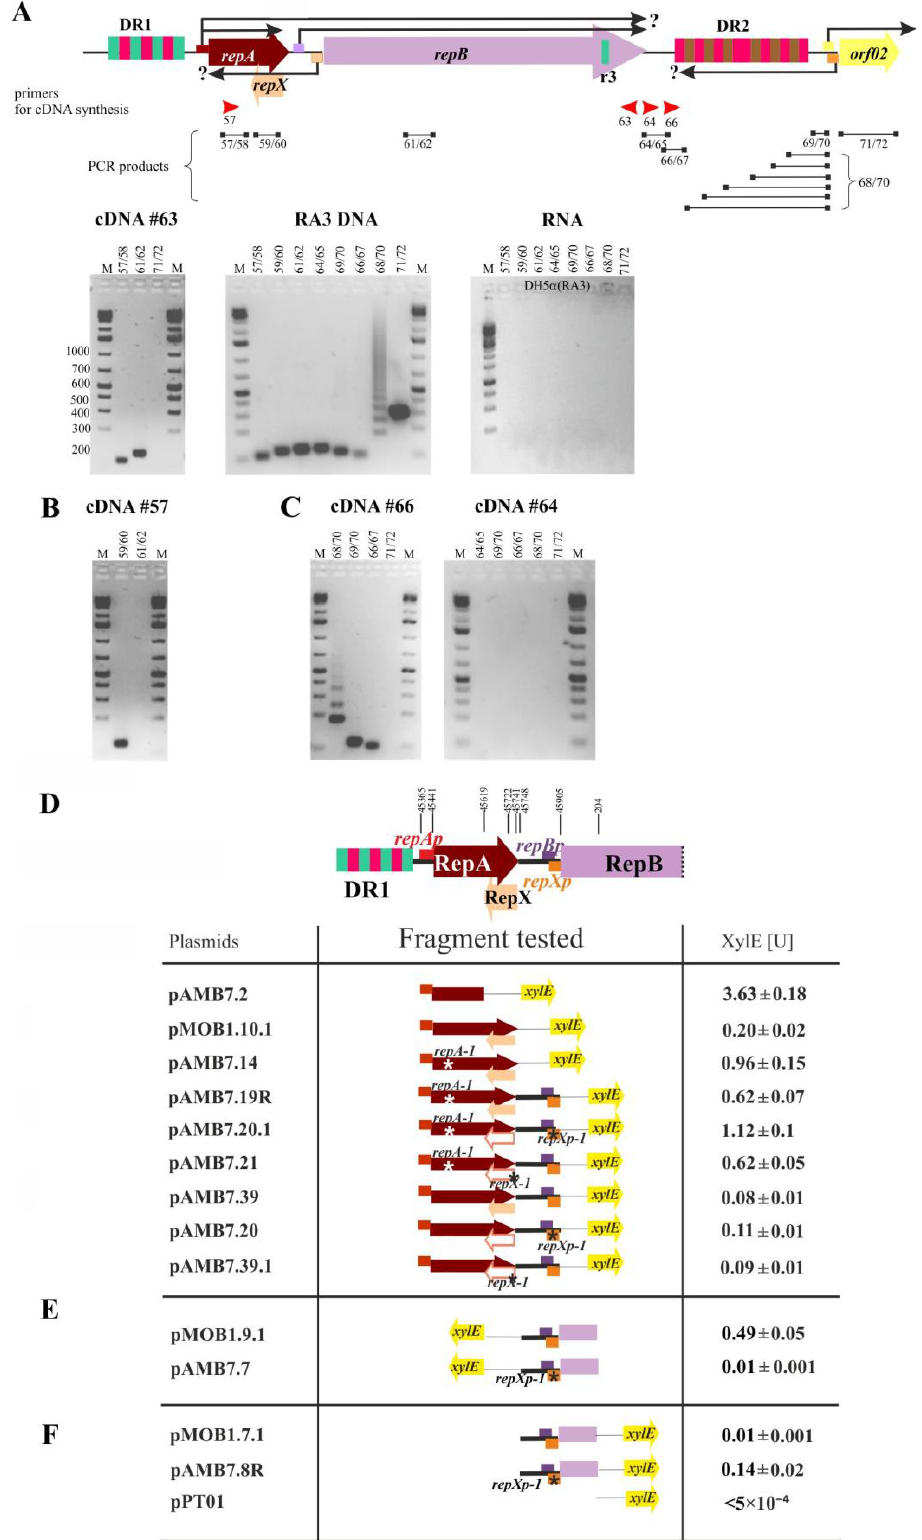
Figure 5. Transcriptional analysis of the repA-repB region. ( A – C ) RT-PCR analysis of the replication module on RNA isolated from DH5α(RA3). The upper part illustrates the location of primers used for cDNA synthesis (red arrows) and the expected PCR products for various primer pairs. ( A ) RT-PCR analysis of the repA-repB co-expression. The results of PCRs on cDNA obtained with primer